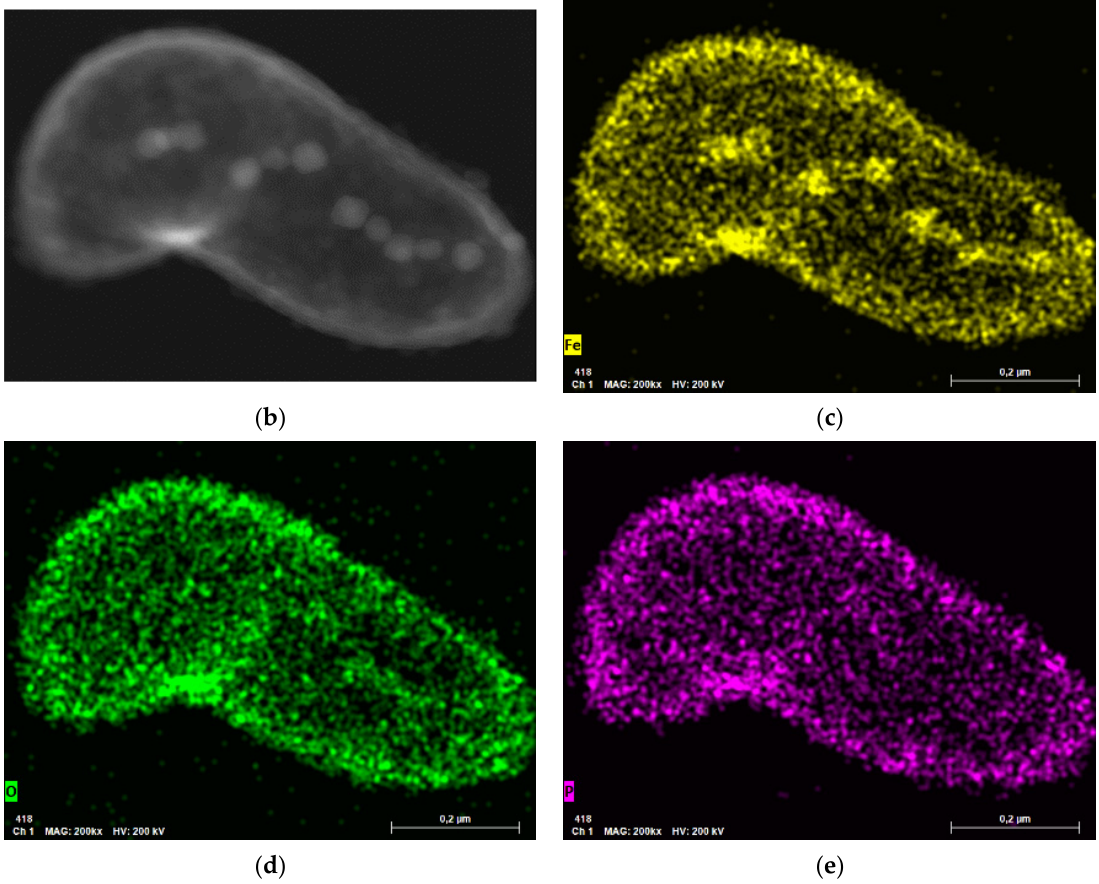
Figure 2. Analysis of the elemental composition of magnetotactic bacteria (MTB) lyophilizate: ( a ) X-ray energy dispersive analysis results; ( b ) internal structure of MTB cell fragment; ( c – e ) X-ray Fe, O, and P mapping of an MTB cell, respec- tively.